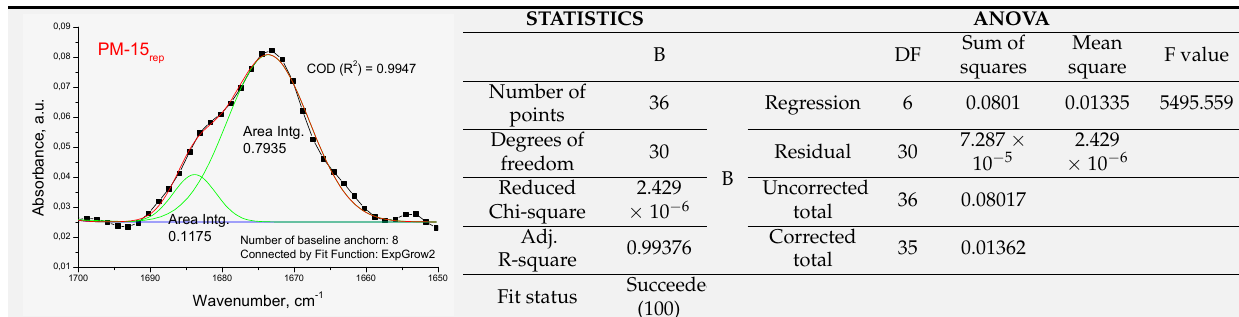
Table A8. Sample P-15 rep.